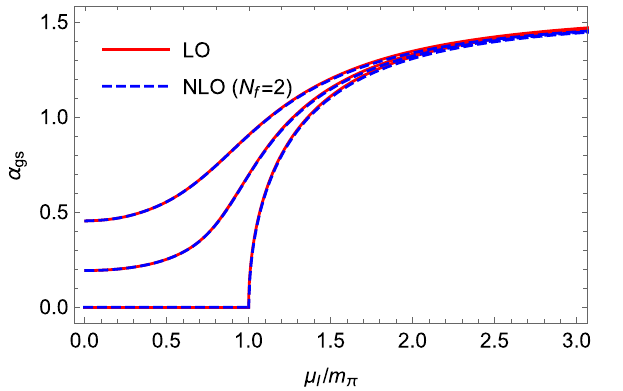
Fig. 1 α gs as a function of μ I / m π from below for j = 0, j = 0 . 00517054 m π and j = 0 . 0129263 m π . Red solid lines are LO results and blue dashed lines are NLO results